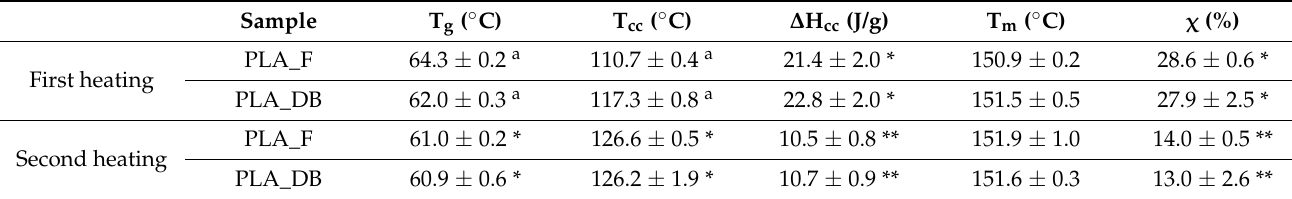
Table 5. Data relevant to DSC